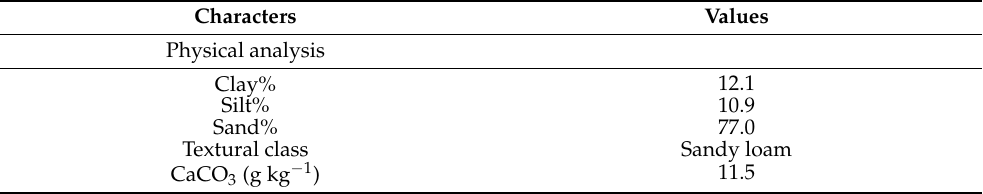
Table 1. Physico-chemical analyses of soils used for CO 2 production